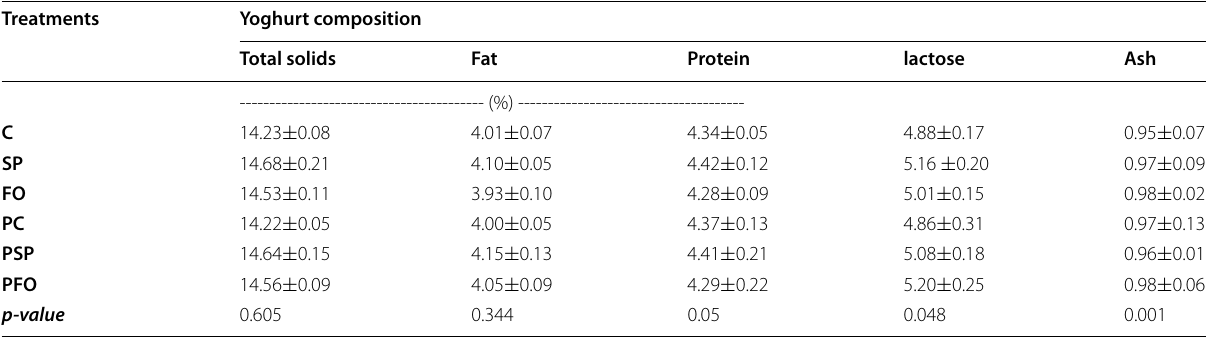
Table 2 Chemical composition of probiotic and non‑probiotic yoghurts made from ewes’ milk fed a diet supplemented with Spirulina platensis or fish